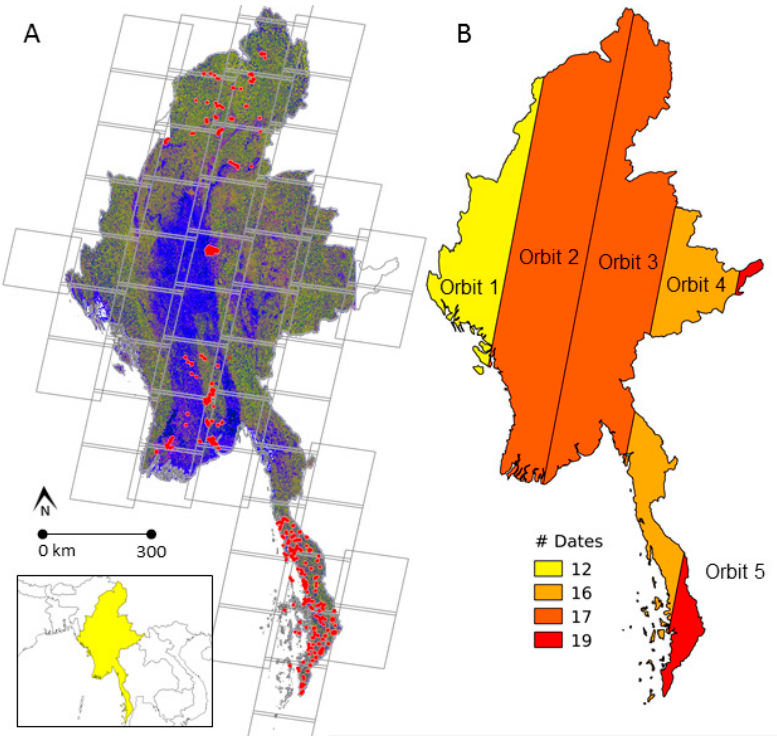
Figure 1. ( A ) Location of training polygons (red) overlaid on 2015 PALSAR-2 (Red: HH, Green: HV, Blue: HH/HV 2 ) Mosaics with Landsat World Reference System path rows shown; ( B ) Orbit paths for Sentinel-1 with heat map of image frequency for 2015.